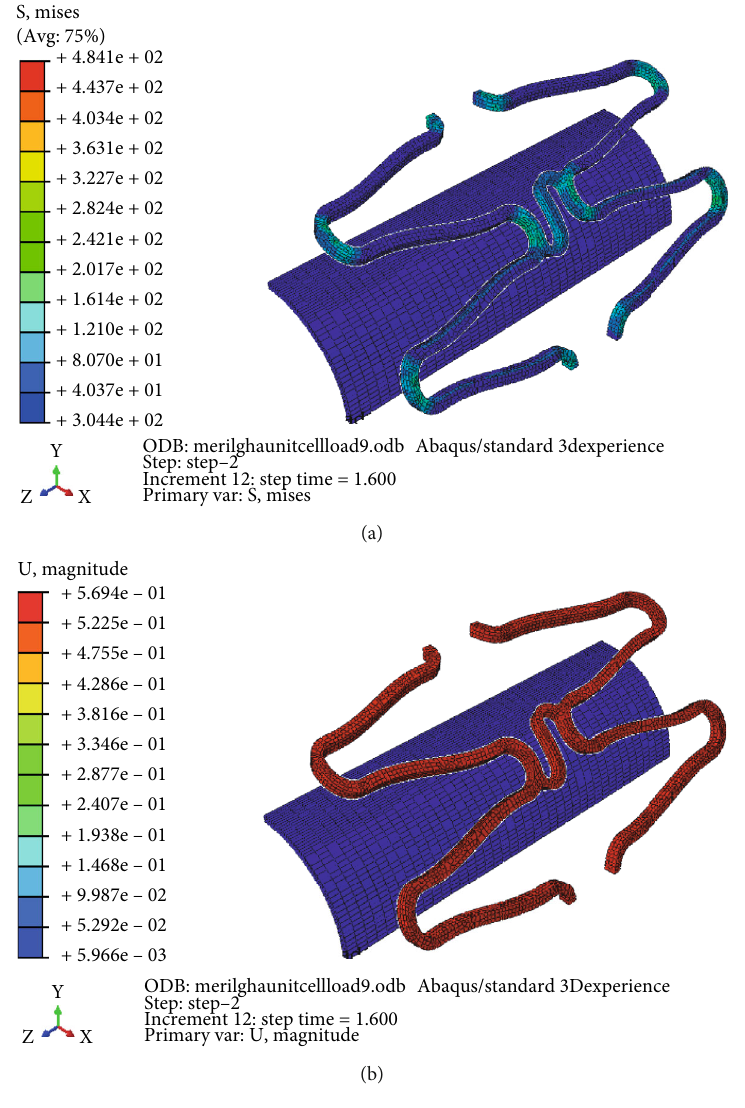
Figure 15: (a) Stress distribution on stent with slight curved connector. (b) Strain distribution on stent with slight curved